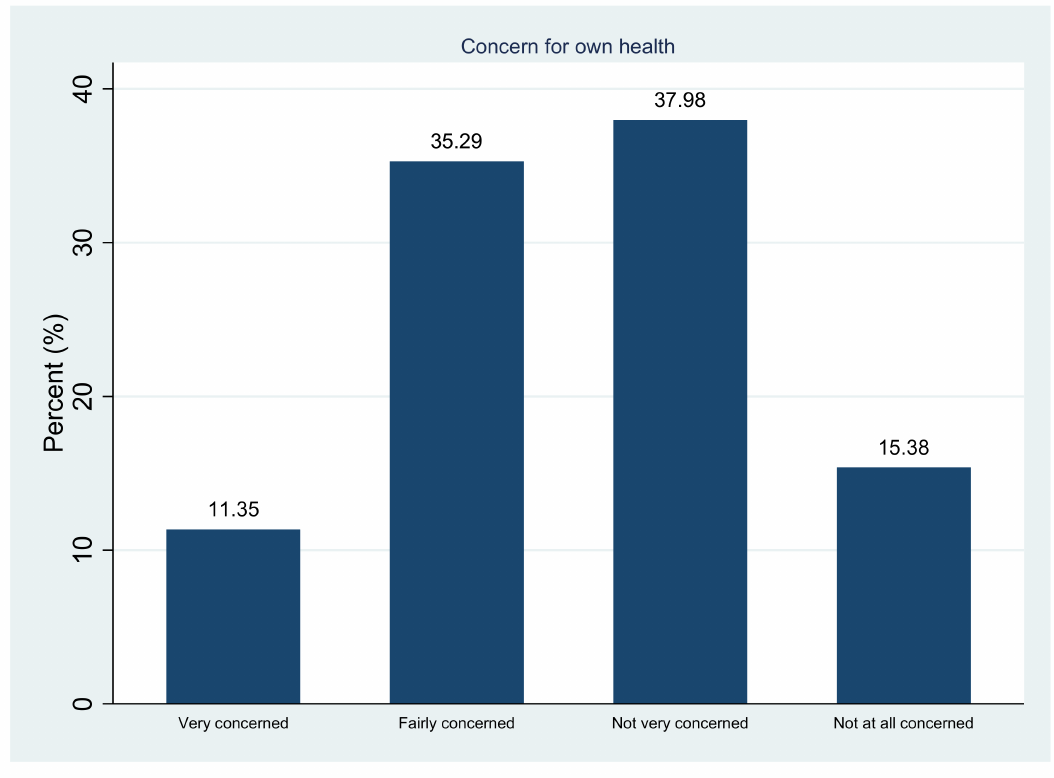
Figure 3. Concern for own